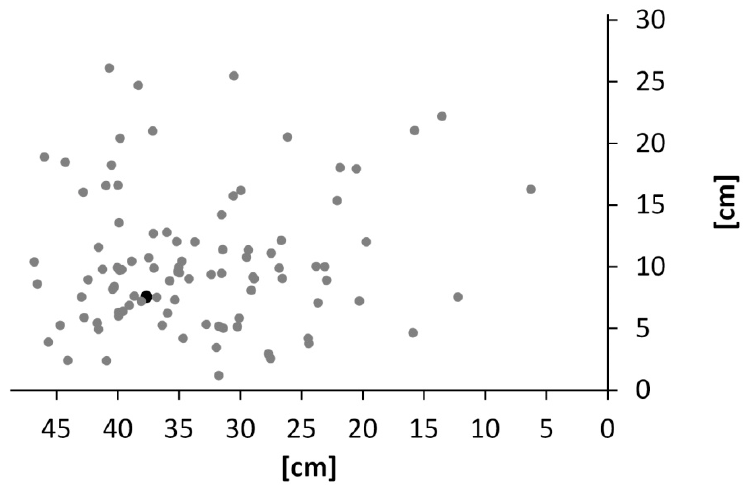
Figure 4. Reaching results for one target point in xy -plane. Target point: black, the participants’ pointing results: grey.